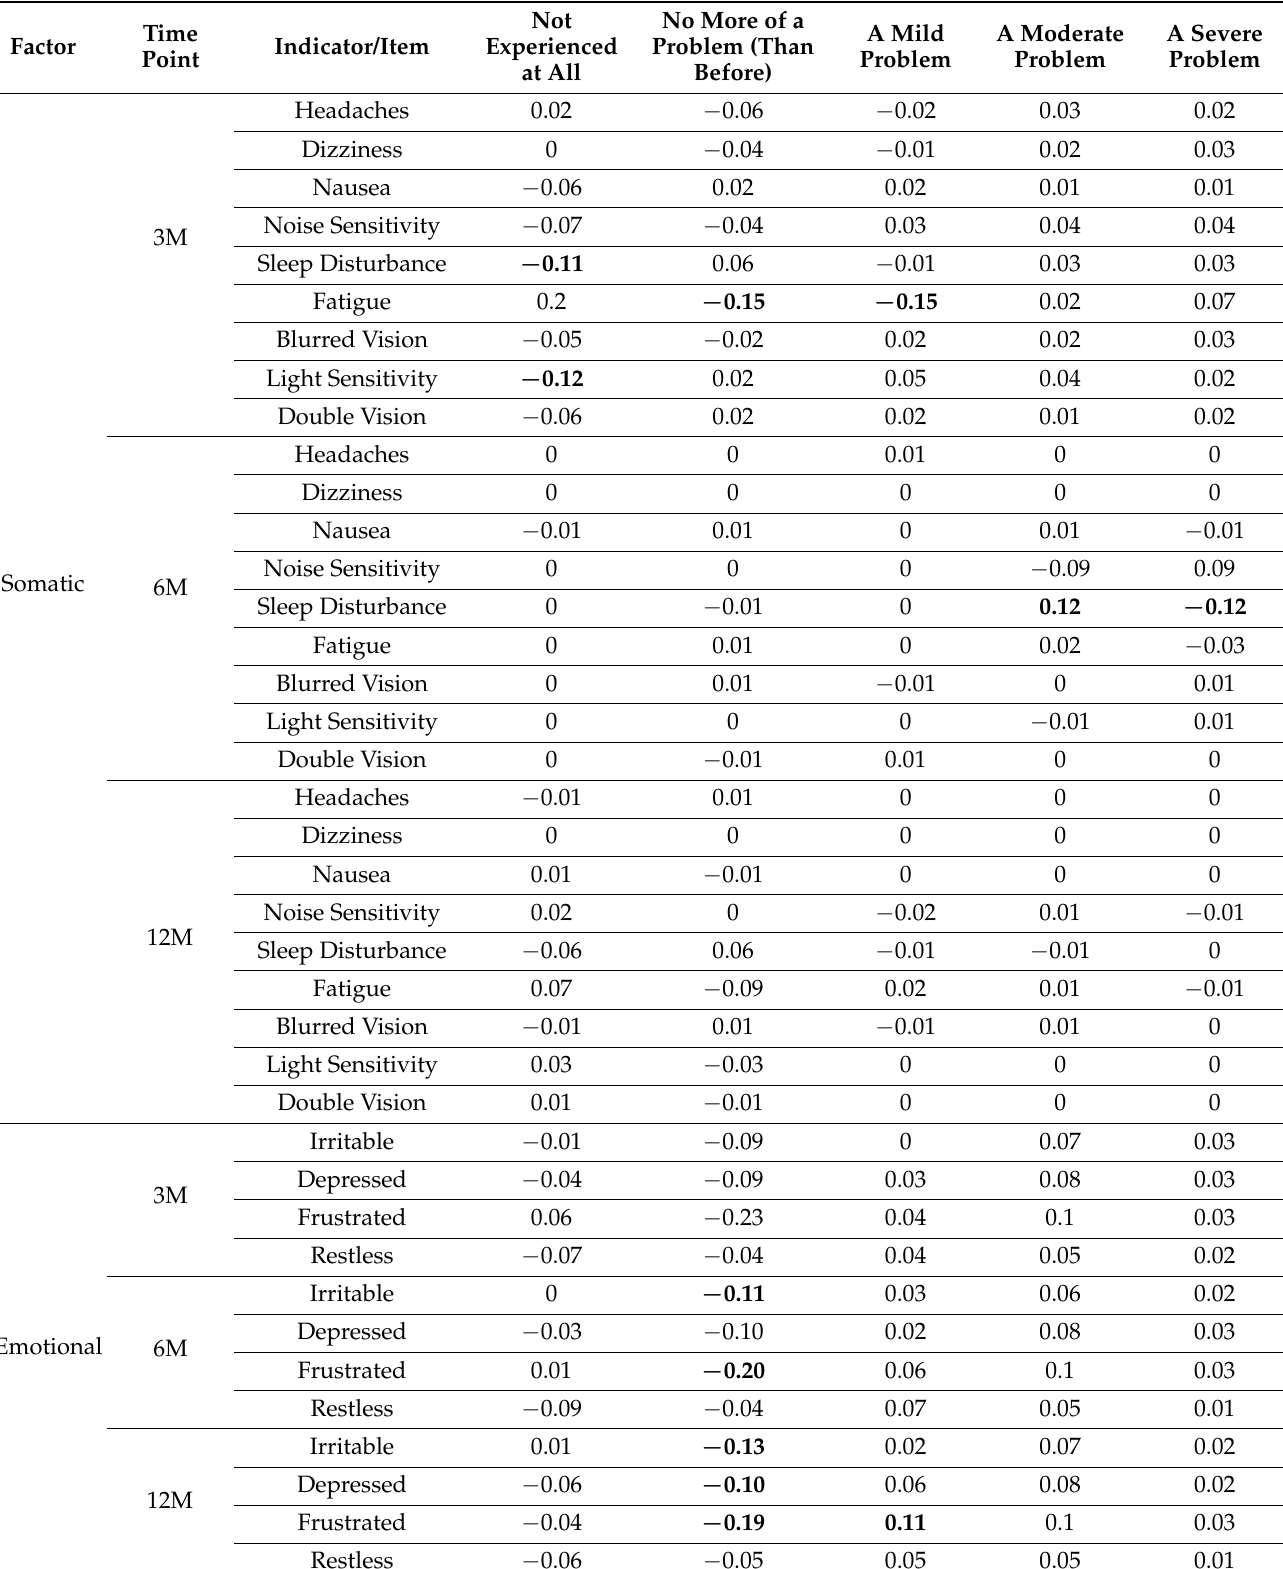
Table A2. Discrepancies in predicted probabilities based on threshold invariance vs. loading invari- ance models for each